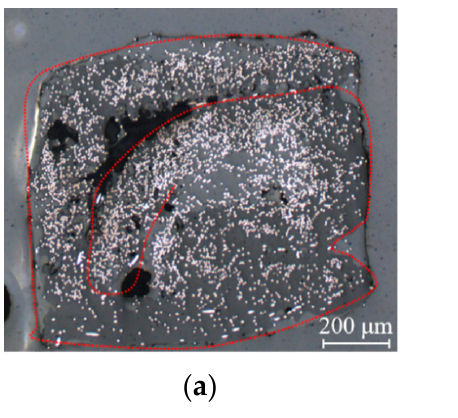
Figure 1. Overall DcAFF filament forming process starting from ( A ) HiPerDiF preform fibre and thin PLA matrix preparation, ( B ) consolidation of HiPerDiF preform and PLA tape, ( C ) bulking tape by designed rolling technique, and ( D ) pultrusion through a series of nozzles.